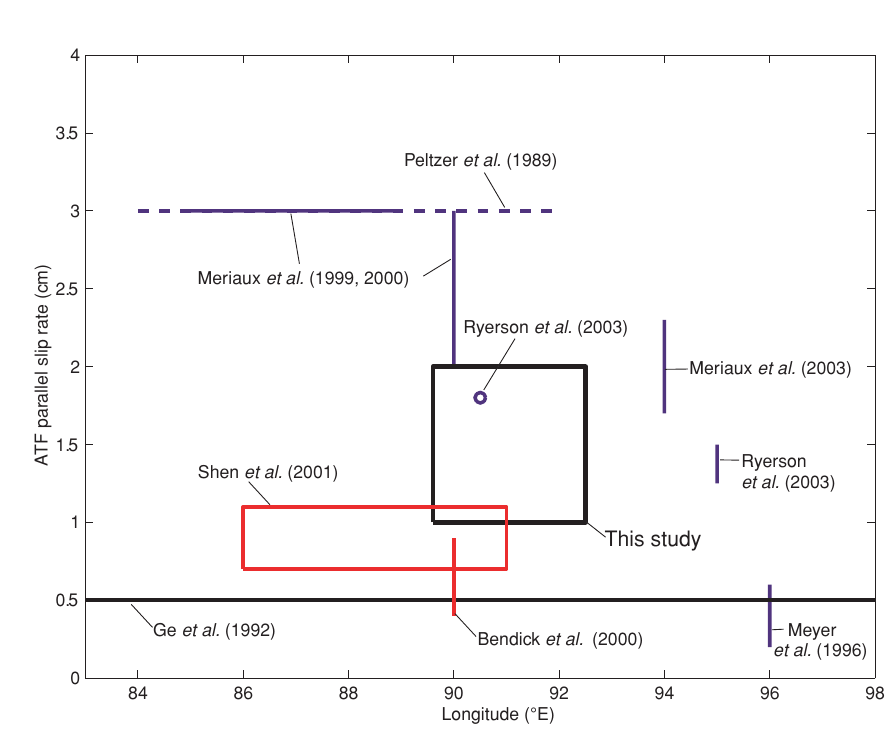
Fig. 10. Inferred Altyn Tagh Fault-parallel slip rates from long-term studies (blue), geodesy (red), and earth- quake geology (black) compiled from the literature and this study. The eastward decrease in slip rate indicated by the long-term studies is consistent with the activity of numerous thrust faults splaying from and to the south of the ATF ( e.g. , Meyer et al. , 1996, 1998; Tapponnier et al. , 2001; although not consistent with the geodetic results from Shen et al. , 2001). In general, the geodetic results show lower slip rates relative to the long-term studies. Our earthquake geology results span the two other methods in both the time scale of measurements (a few kyr versus decadal and > (cid:190) 10 kyr) and the resulting inferred